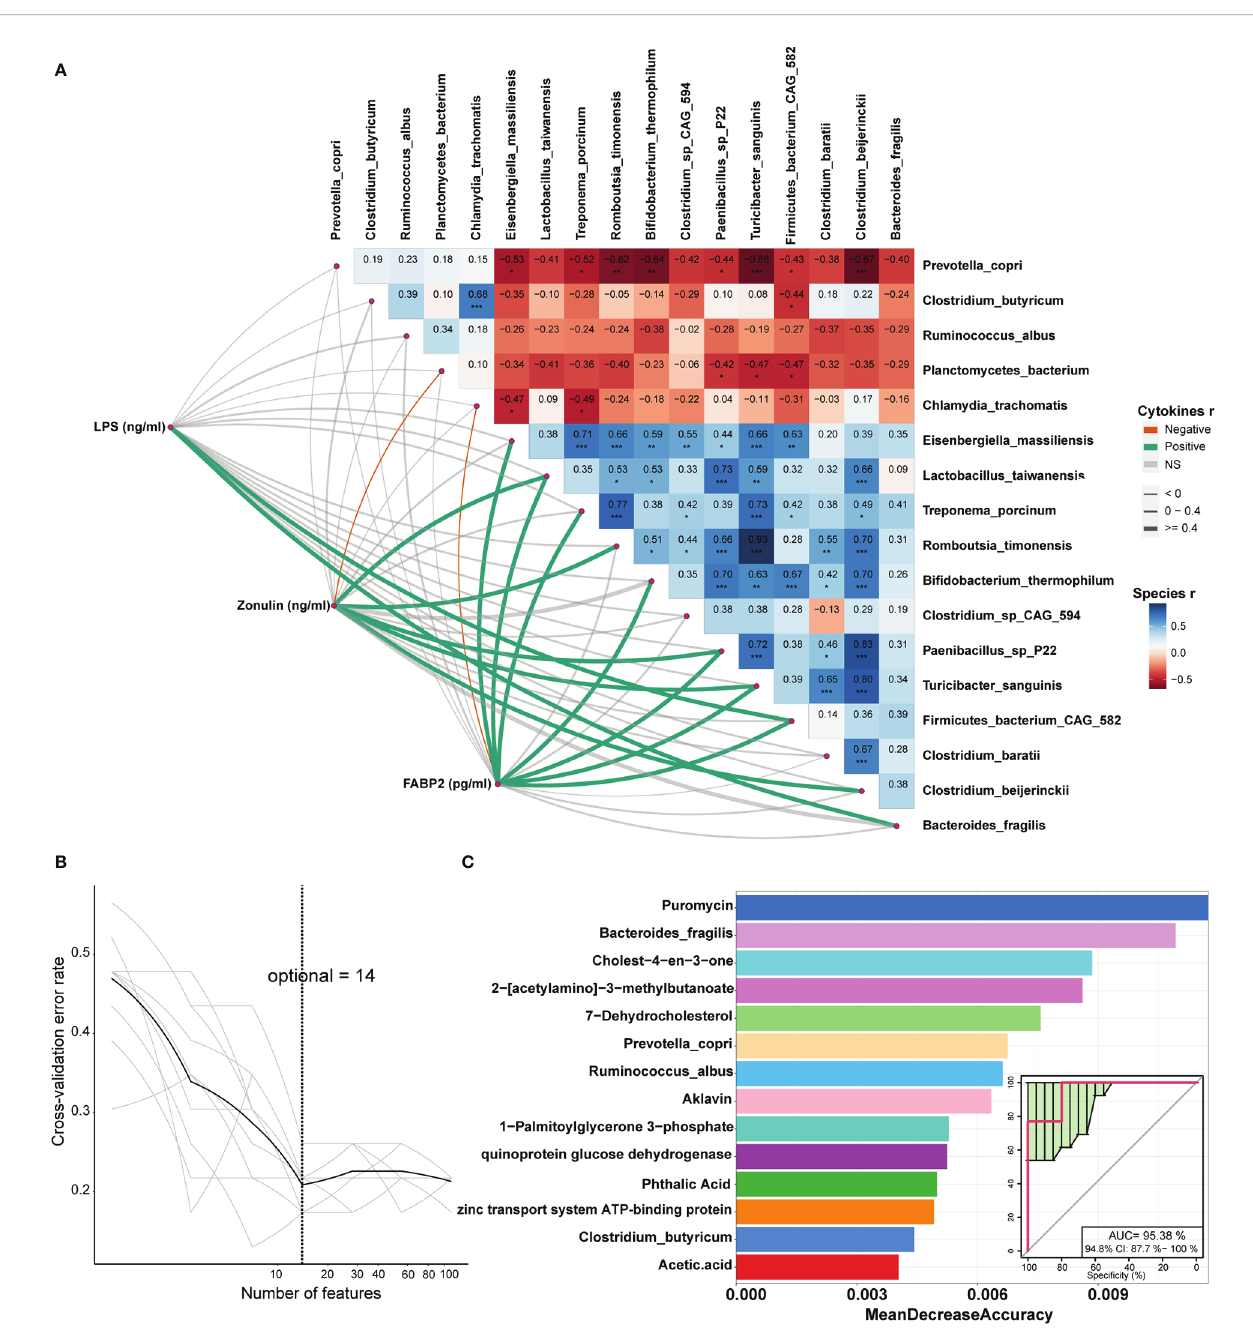
FIGURE 8 Correlations between cytokines and differential bacterial species and identi fi cation of the biomarkers that could be used to classify the sows giving birth to stillborn piglets by Random Forest. (A) The values on the heatmap represent the Spearman correlation coef fi cient between bacterial species which were enriched in each of two sow groups. *, P < 0.05, **, P < 0.01, and ***, P < 0.001 obtained in the Spearman ’ s rank correlation test. The lines represent the Spearman correlation between cytokines and bacterial species, the green lines indicate a positive correlation, the orange lines show a negative correlation, and the grey lines indicate the correlation that did not achieve signi fi cance level. (B) The tenfold cross-validation by Random Forest model. (C) The 14 features that could discriminate the stillbirth and normal